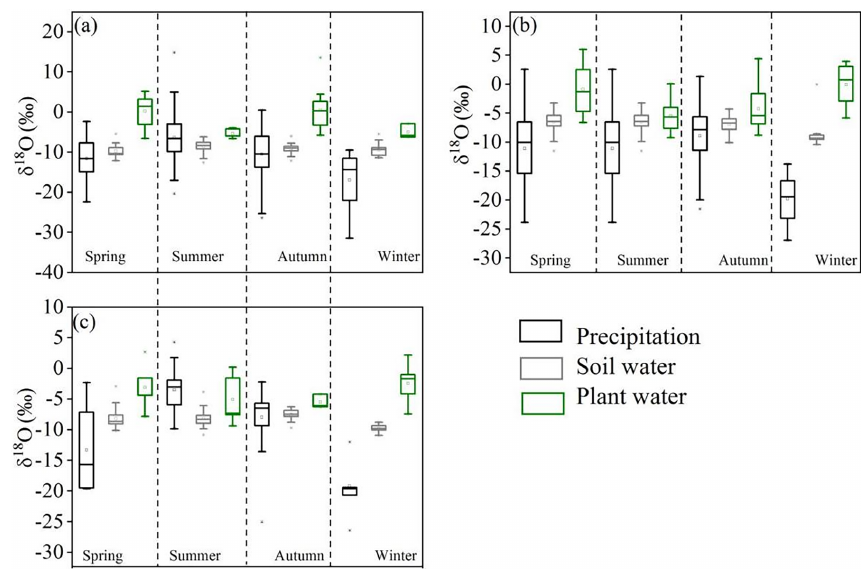
Figure 6. Seasonal variations in different water isotopes in alpine meadow (a) , forests (b) , and arid foothills (c) . Table 3. Correlation between precipitation isotopes and different temperatures in different vegetation zones. Vegetation zone type Correlation below 0 ◦ C Correlation between 0– Correlation above 8 ◦ C Correlation during ( δ 18 O/ δ D) 8 ◦ C ( δ 18 O/ δ D) the study period ( δ 18 O/ δ D) ( δ 18 O/ δ D) Alpine meadow 0.51 ∗ /0.59 ∗ 0.30 ∗ /0.24 ∗ 0.15/0.12 0.59 ∗ /0.61 ∗ Forest 0.95 ∗ /0.94 ∗ 0.66 ∗ /0.69 ∗ 0.14/0.10 0.69 ∗ /0.65 ∗ Arid foothills 0.47/0.51 0.79 ∗ /0.71 ∗